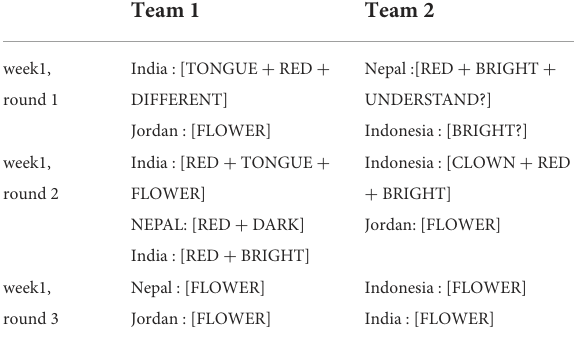
TABLE 3 Variants for “pink” produced by each participant during week